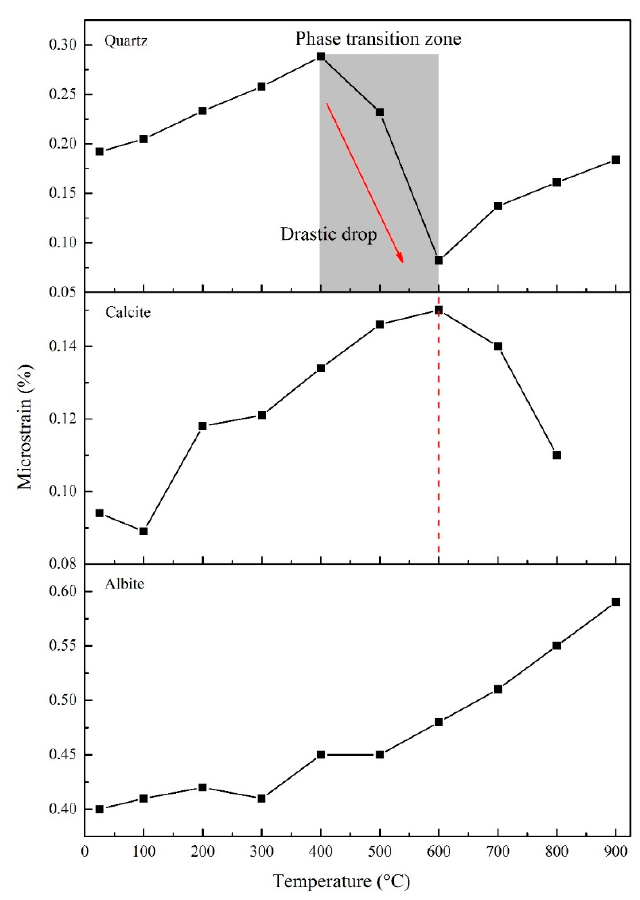
Figure 4. Microstrain curves as a function of temperature for quartz, calcite and albite.